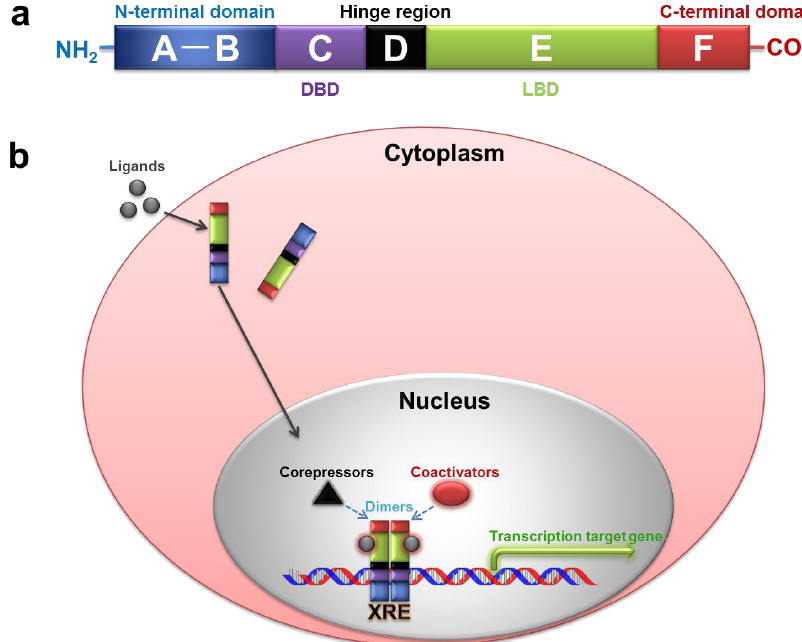
Figure 1. Schematic structure of NRs (nuclear receptors) and model of NR signalling. ( a ) General domain structure of NRs; and ( b ) the mechanism of general NR action. The ligands bind to the LBD (ligand-binding domain) of NRs in the cytoplasm, and translocate to the nucleus. Then the DBD (DNA-binding domain) of NRs bind to the XRE (xenobiotic responsive elements) forming dimeric complexes with RXR and the recruitment of co-activators or co-repressors. Finally, this leads to the transcription of the target genes. This model is applied to type II NRs, including PPARs, CAR, LXRs, and others. The colorful words just match the corresponding colorful shape. The dotted arrows mean different ligands can recruit coactivators or corepressors to form dimers, respectively.